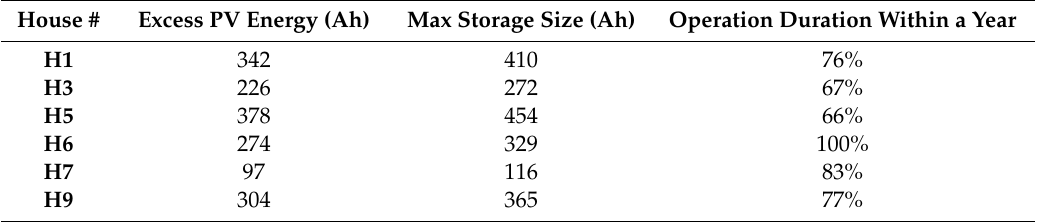
Table 7. Maximum energy storage size requirement for selected houses in